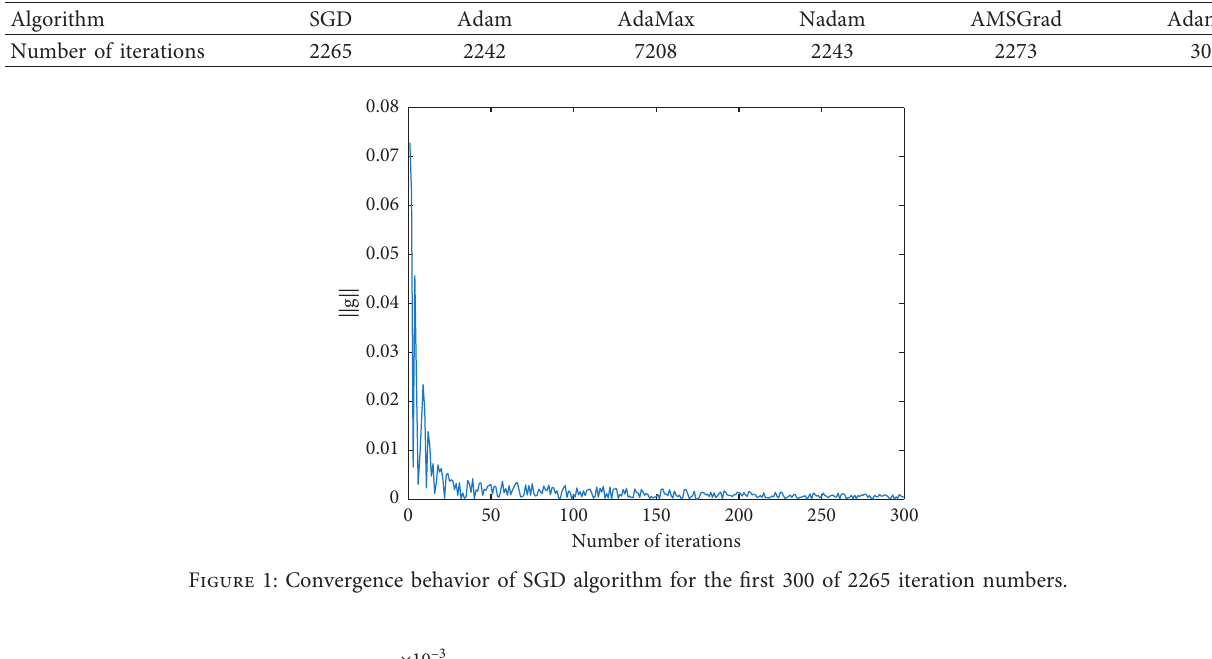
Table 3: Performance of algorithms.